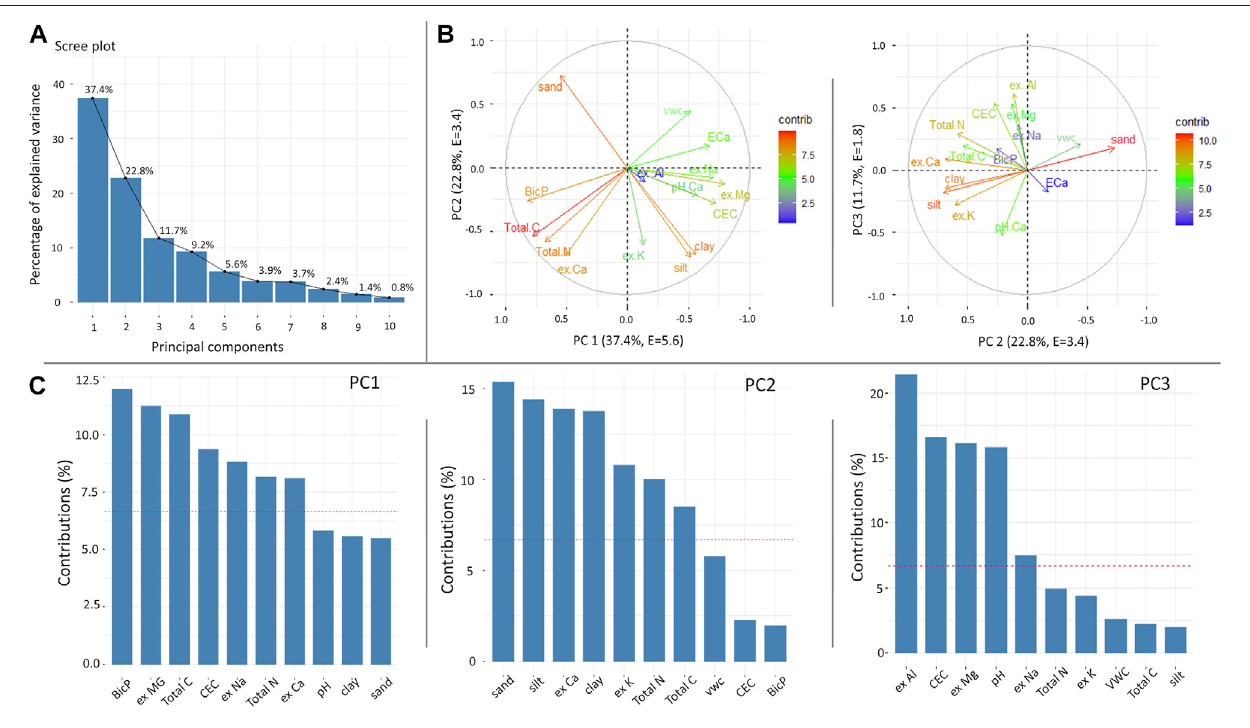
FIGURE 10 | Principal component analysis for Kukerin soil parameters showing (A) scree plot, (B) variables highlighted based on their percent contribution in correlation plots, and (C) contribution of variables in selected PCs, where the red line shows the expected average contribution (cut-off). The soil variables included are sand, silt, clay, volumetric water content, pH, CEC, Total N &Total C, ex Mg, ex Na, ex Ca, ex Al, ex K, BicP, and inverted EC from 10 m around each sample.